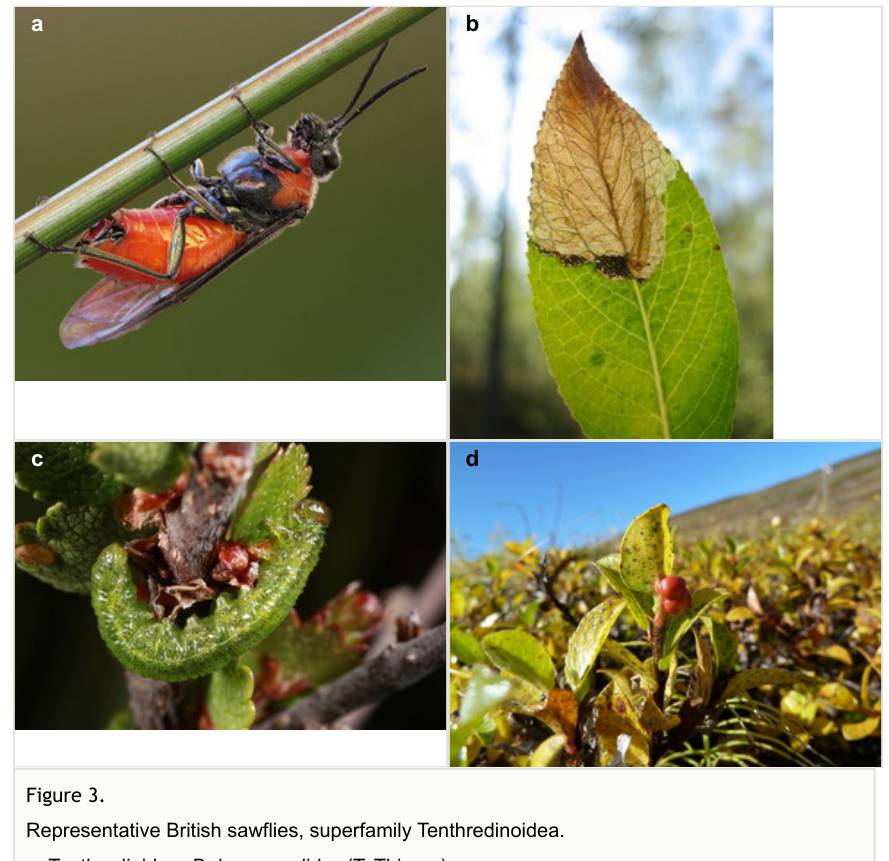
Figure 3. Representative British sawflies, superfamily